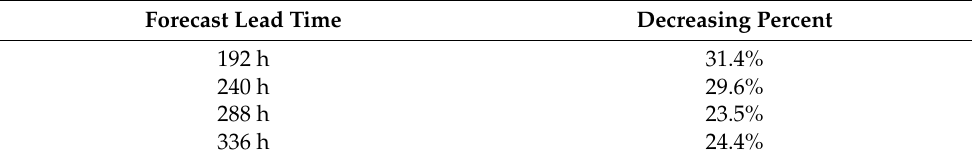
Table 2. The decreasing percent of RMSE of the